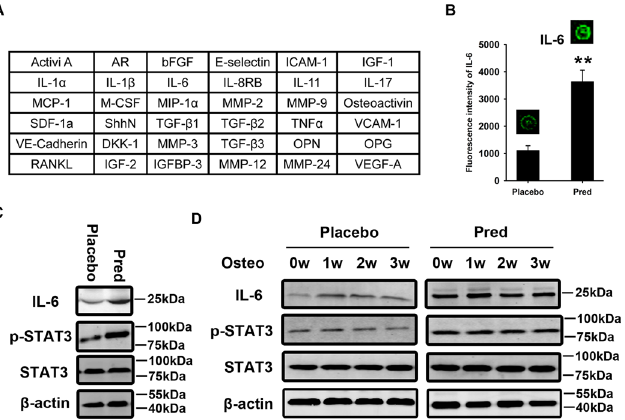
Fig 3. IL-6-STAT3 signaling is over-activated in osteoporotic BMSCs. The expression of thirty-six important bone metabolism markers was measured in normal and osteoporotic BMSCs treated with BMP2 for 7 days using an antibody array (A) . The fluorescence intensity represents the relative expression level of the indicated protein. Of the thirty-six bone metabolism markers investigated, interleukin-6 (IL-6) was found to be upregulated in osteoporotic BMSCs compared with normal BMSCs (B) . The data are shown as the mean ± SD. Total protein was harvested from the normal and osteoporotic BMSCs and subjected to western blotting using IL-6, p-STAT3, and STAT3 antibodies (C) . Normal and osteoporotic BMSCs were induced to undergo osteogenesis. Zero, 1, 2, and 3 weeks after induction, total protein was harvested for western blotting using IL-6, p-STAT3, and STAT3 antibodies (D) . β -actin was used as an internal control. ** : p < 0.01, Pred vs .